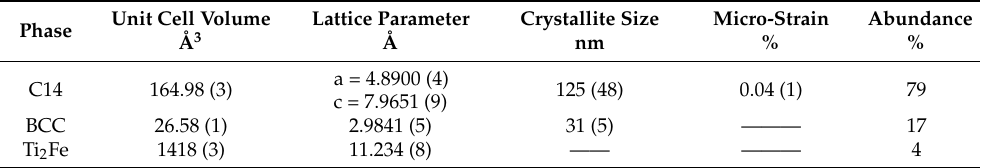
Figure 3. X-ray diffraction patterns of as-cast Ti 0.3 V 0.3 Mn 0.2 Fe 0.1 Ni 0.1 alloy. The bottom curve is the difference between calculated and measured intensities. Table 3. Crystal parameters and abundance of each phase of as-cast Ti 0.3 V 0.3 Mn 0.2 Fe 0.1 Ni 0.1 alloy. Error on the last significant digit is indicated in